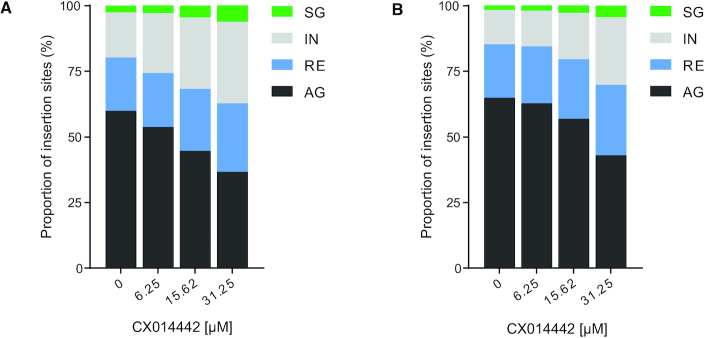
LEDGIN treatment retargets integration away from active genes. Integration sites retrieved in each condition in SupT1 (A) and Jurkat (B) cells were divided in four genomic categories and plotted as relative proportions: silent genes (SG), intergenic regions (IR), regulatory elements containing enhancers and promoters (RE) and active genes (AG).